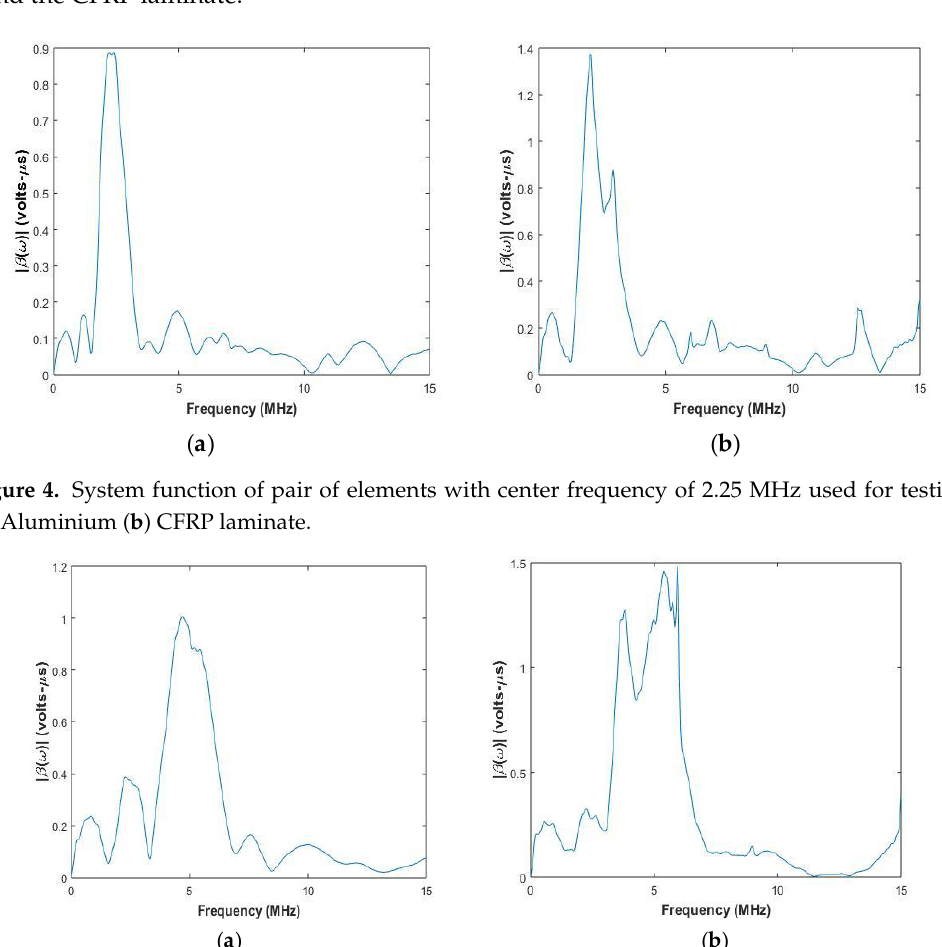
( b ) Figure 3. ( a ) Total reflection coefficient for aluminum ( b ) Total reflection coefficient for CFRP